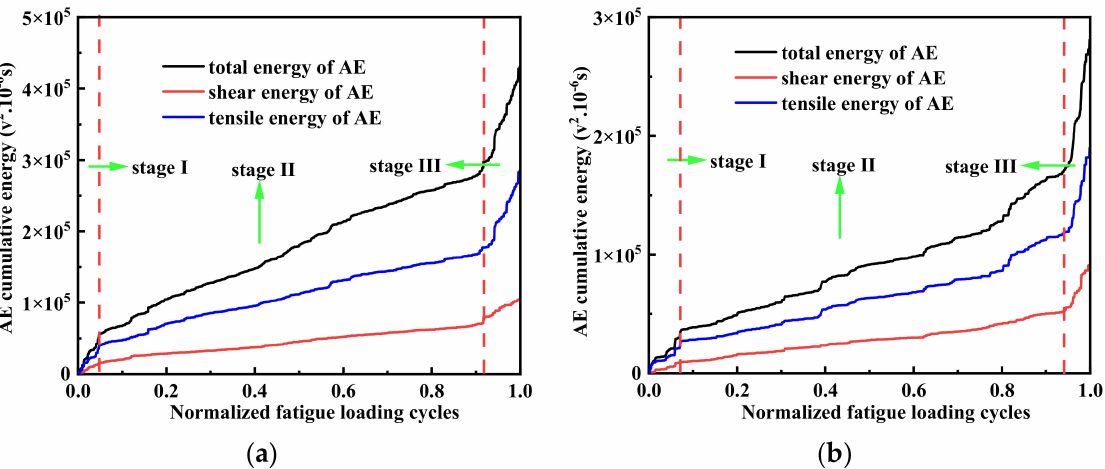
Figure 17. The cumulative energy evolution law of different types of AE during fatigue loading process based on the RA and AF values. ( a ) Sample F2-1; ( b ) Sample